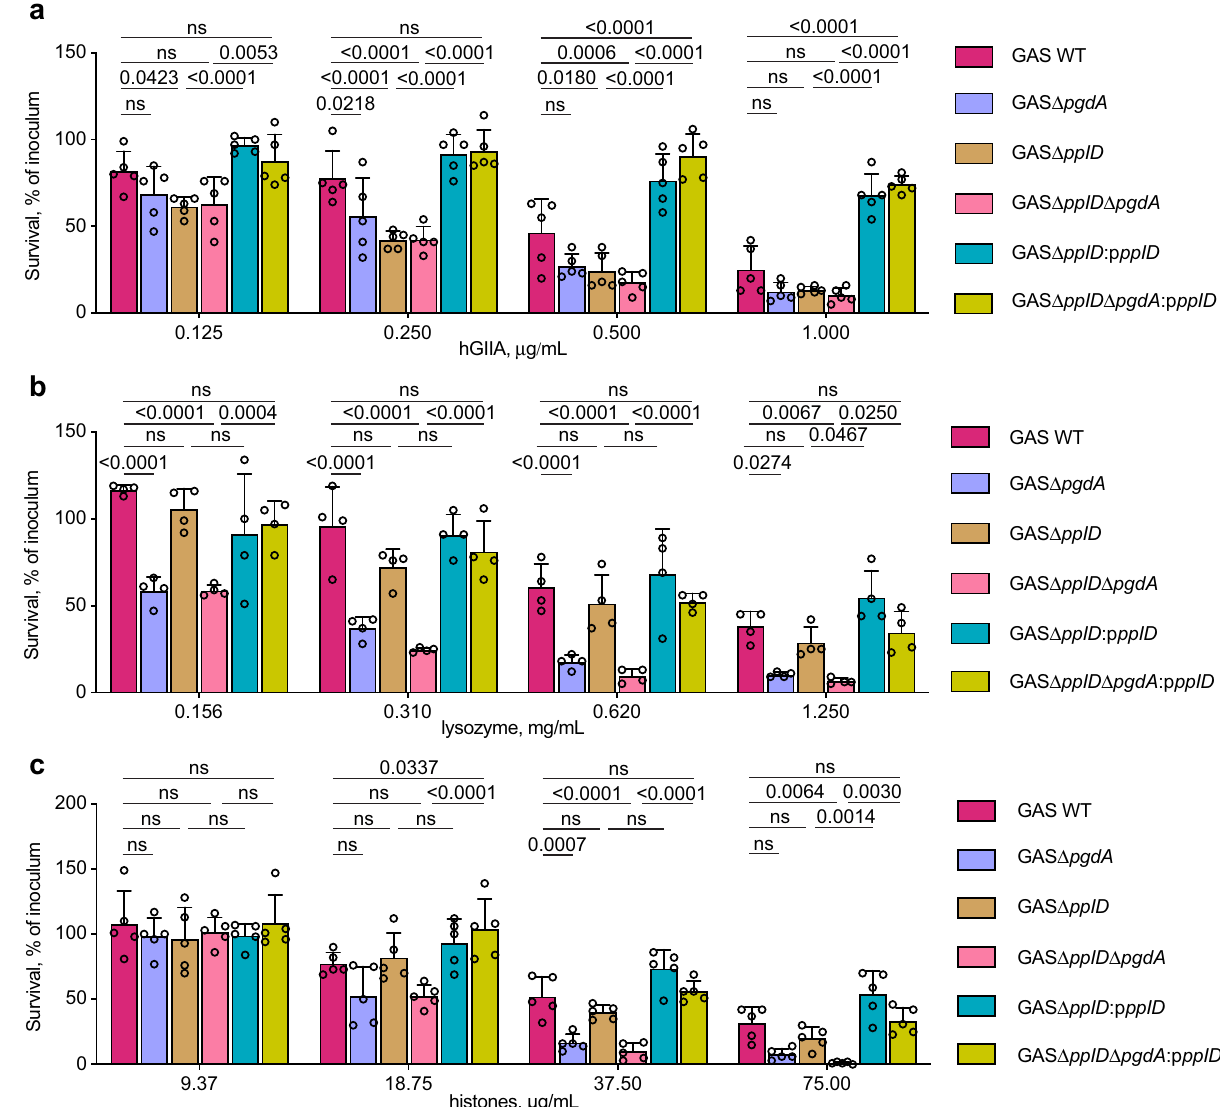
Fig. 6 N -deacetylases PplD and PgdA contribute to protection of GAS against AMPs. a – c Analysis of resistance of GAC mutants de fi cient in N - deacetylation of GlcNAc mediated by PplD and PgdA to a hGIIA, b lysozyme, and c histone mixture. Data are mean values ± S.D., n = 5 biologically independent experiments in ( a , c ), n = 4 biologically independent experiments in ( b ). P values were calculated by two-way ANOVA with Bonferroni ’ s multiple comparison test. Source data are provided as a Source data fi